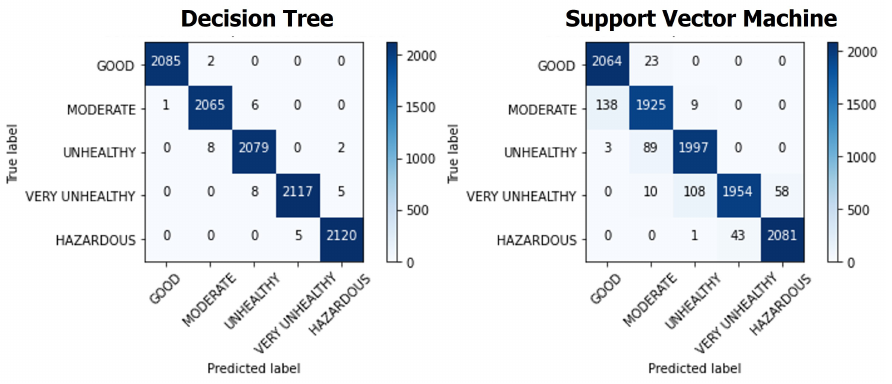
Figure 8. Confusion matrices of Decision Tree and Support Vector Machine